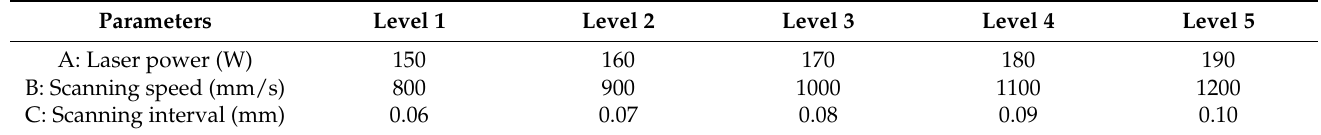
Table 2. The process parameters and their levels used in this study.